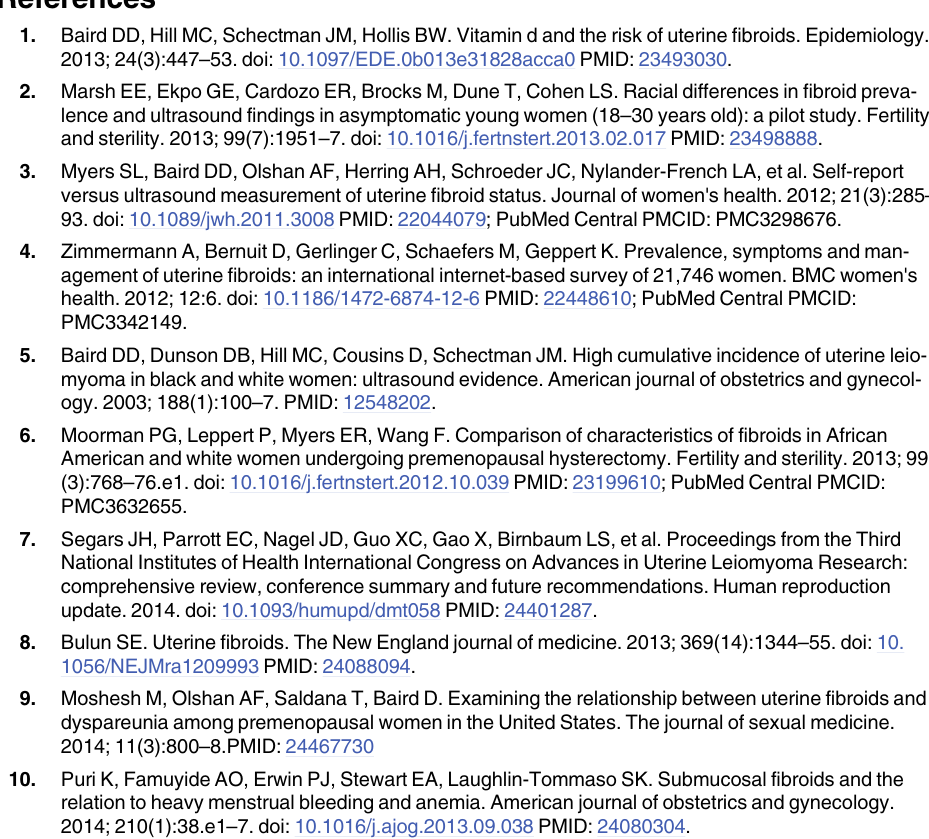
S41 Fig. Presurgical medical treatment-operating time-cumulative ranking probability. (JPG) S42 Fig. Presurgical medical treatment-haemoglobin-forest plot. (JPG) S43 Fig. Presurgical medical treatment-haemoglobin-network plot. (JPG) S44 Fig. Presurgical medical treatment-haemoglobin-probability of best treatment. (JPG) S45 Fig. Presurgical medical treatment-haemoglobin-cumulative ranking probability. (JPG) S1 PRISMA Checklist. Completed PRISMA Checklist for